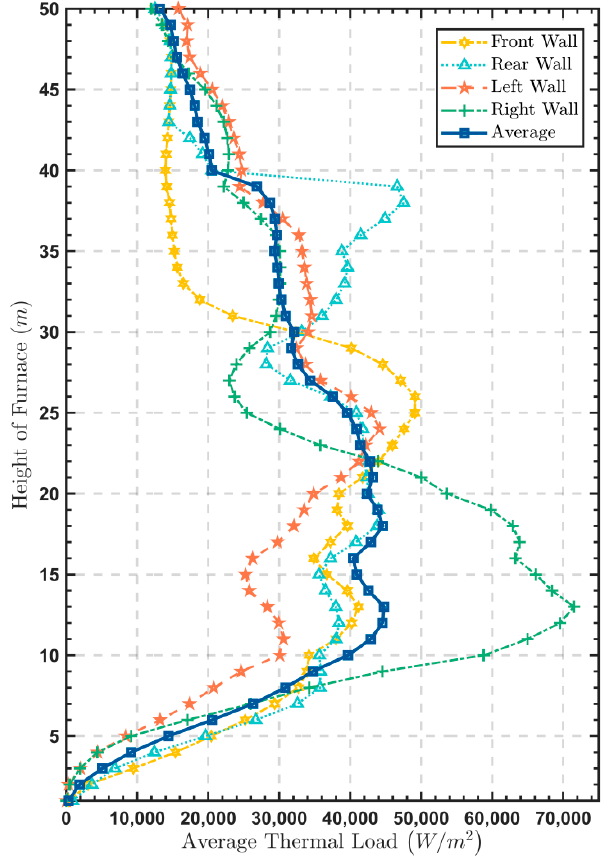
Figure 10. Diagram of Numerical Simulation of Water-cooled Wall Thermal Load Distribution.